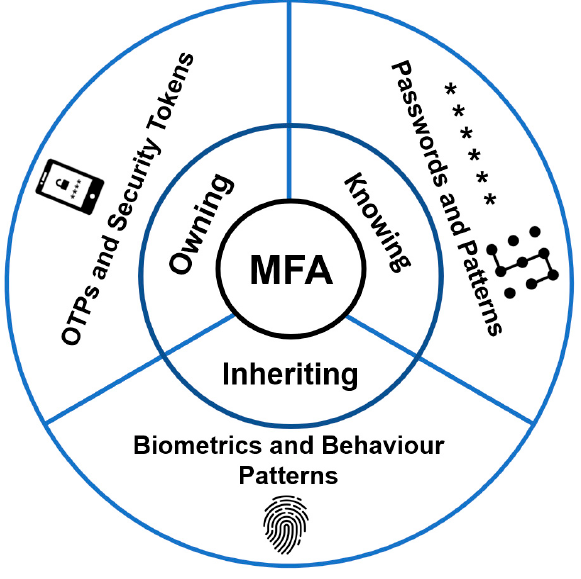
Figure 5. MFA criteria categories .